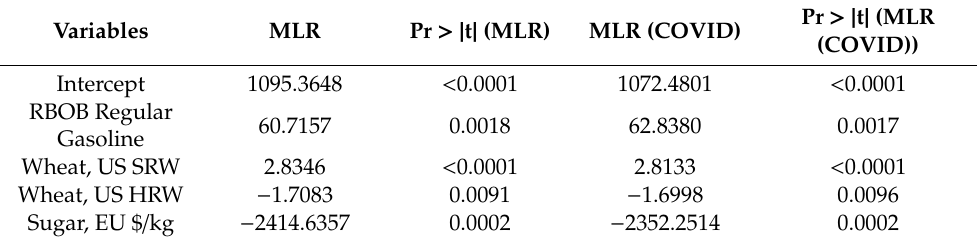
Table 4. Major influencing factors of European ethanol